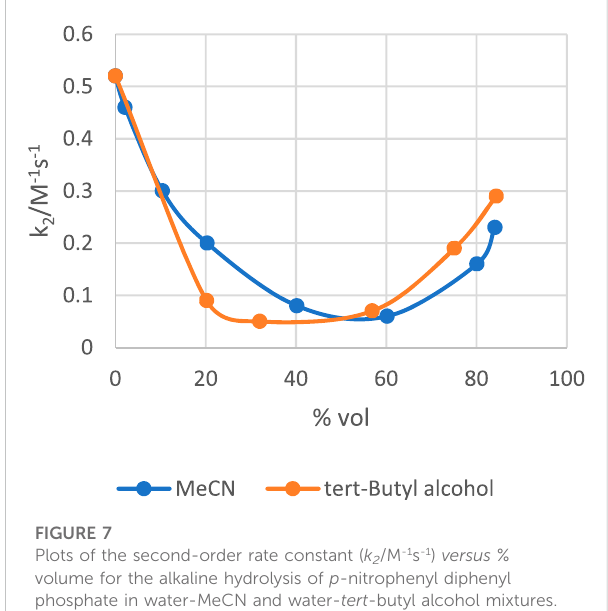
FIGURE 7 Plots of the second-order rate constant ( k 2 /M -1 s -1 ) versus % volume for the alkaline hydrolysis of p -nitrophenyl diphenyl phosphate in water-MeCN and water- tert -butyl alcohol mixtures. Data taken from the work of Bunton et al.